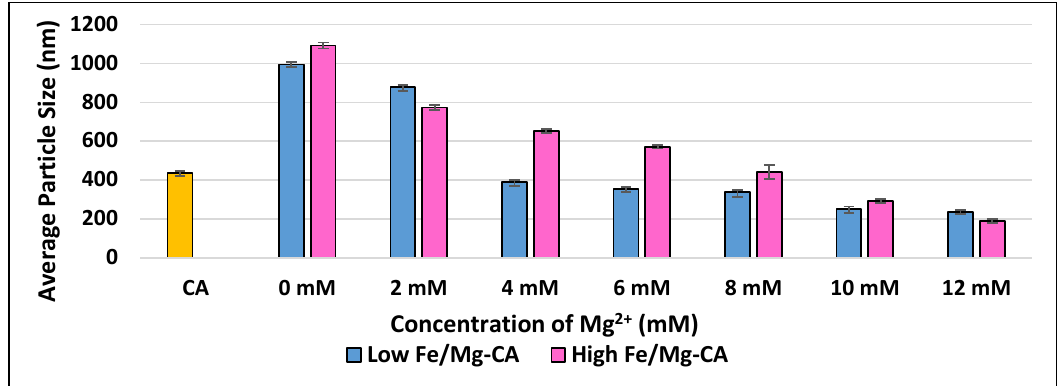
Figure 2. The z-average diameter of low and high Fe/Mg-CA NPs formed by mixing increasing concentrations of exogenous Mg 2+ in a fixed concentration of exogenous Ca 2+ (4 mM Ca 2+ ) and two different (low and high) concentrations of Fe 3+ , 1 µM and 5 µM, respectively in 1 mL DMEM, prior to incubation at 37 °C for 30 min, and supplementation with 10% FBS.